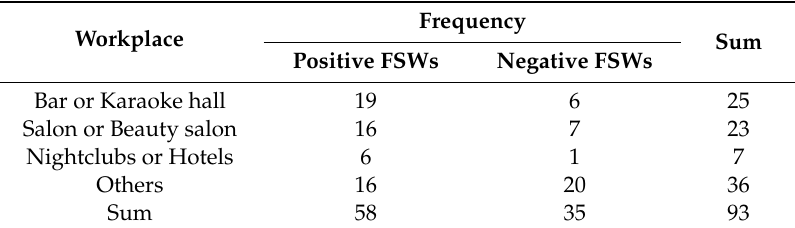
Table A6. Contingency table for chi-square test.